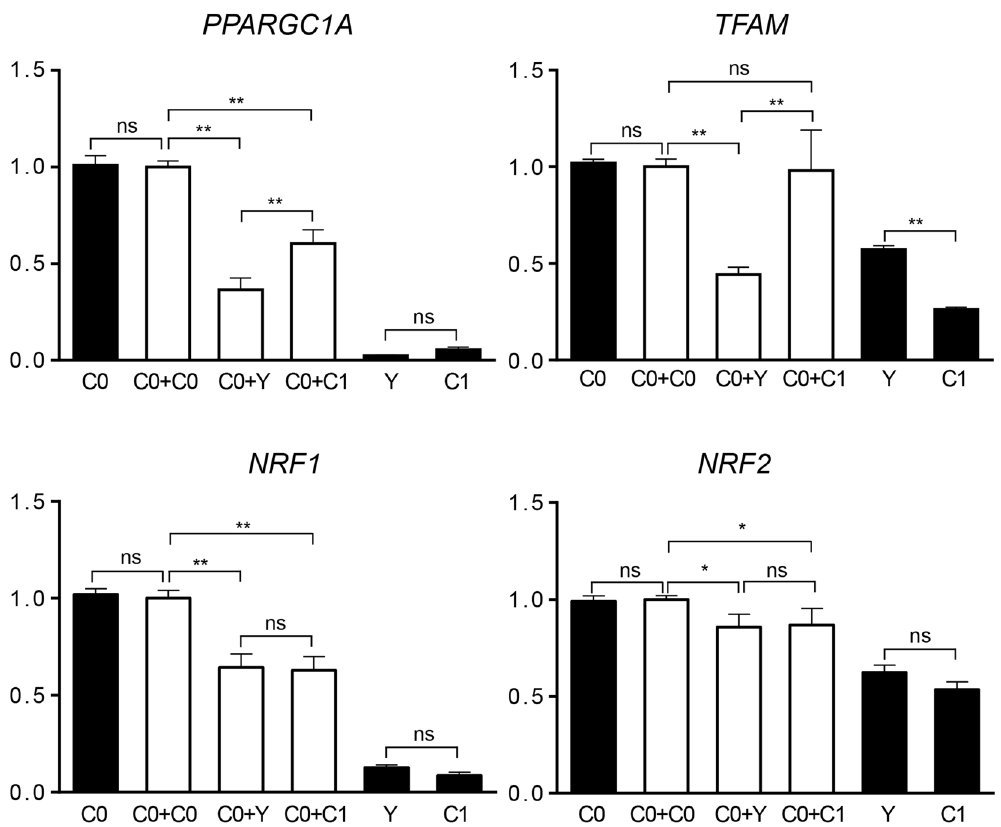
Figure 4. Expression levels of four mitochondrial biogenesis related genes in cybrid cells. Black columns, primary cells; white columns, cybrid cells. Bars indicate the standard deviation (SD), n = 3 per group. * P < 0.05, ** P < 0.01 and ns P >